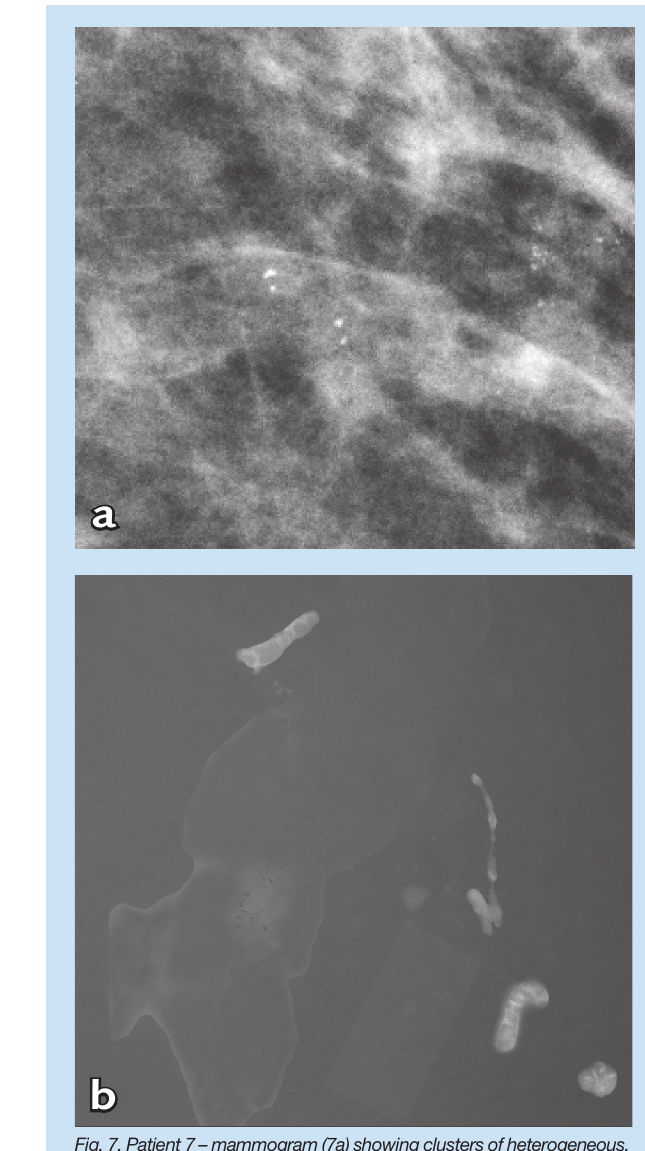
Fig. 7. Patient 7 – mammogram (7a) showing clusters of heterogeneous, punctuate calcifications; calcification pattern is benign. A radiograph (7b) of specimens demonstrates that calcifications have been removed in biopsy.